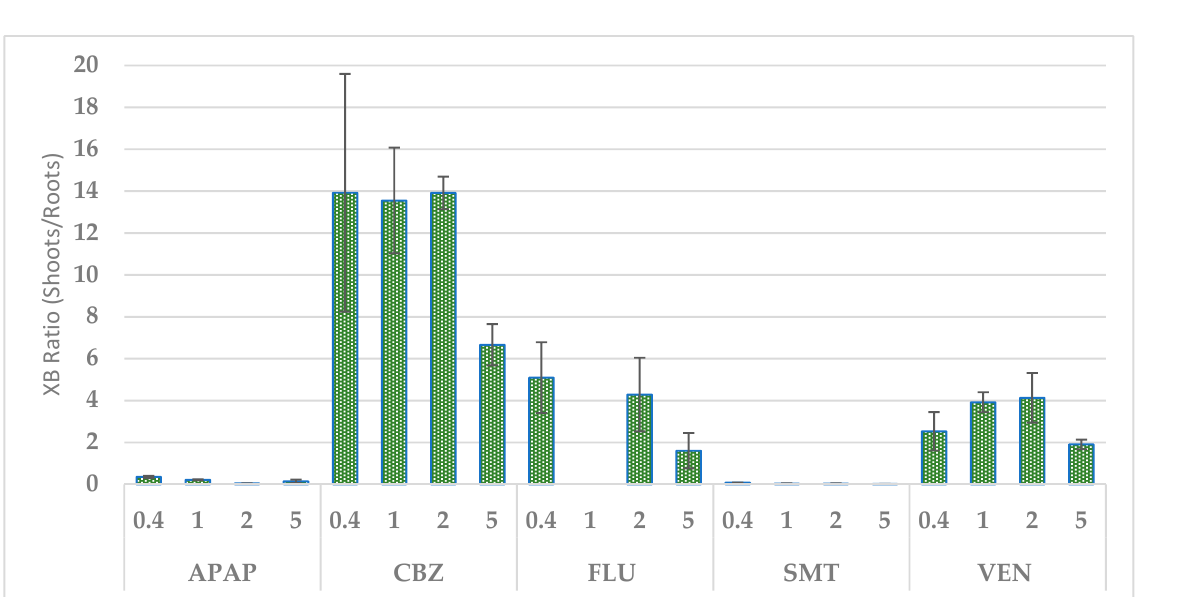
than in the root samples, indicating a higher translocation (Figure 4).